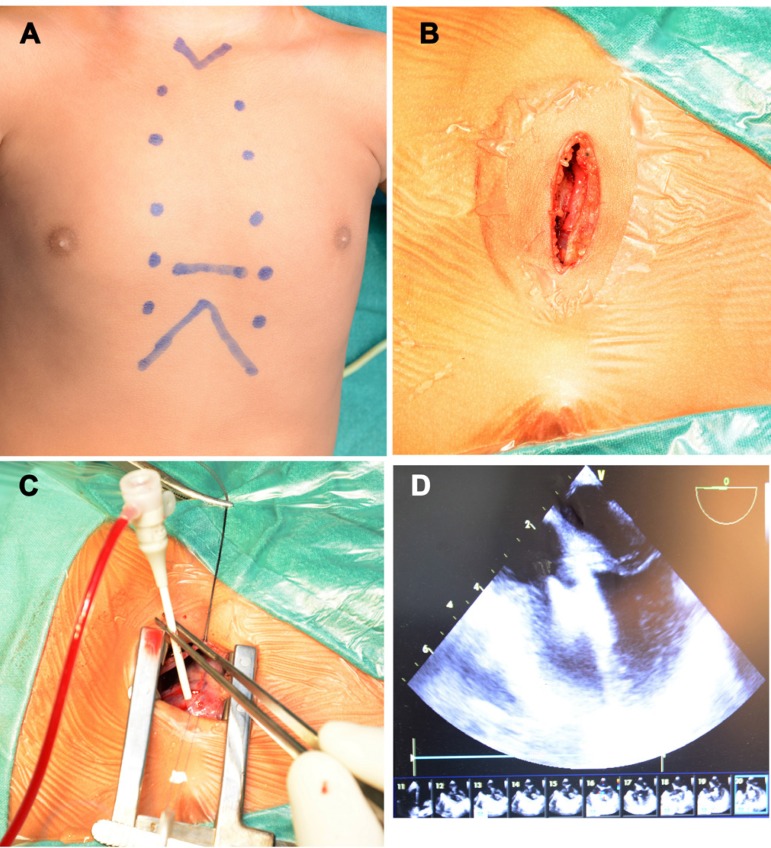
Operative photograph showing proposed incision (A) and transverse
sternotomy (B). C - Showing sheath punctured through RV free
wall. D - Showing echocardiographic image of VSD device
in-situ.